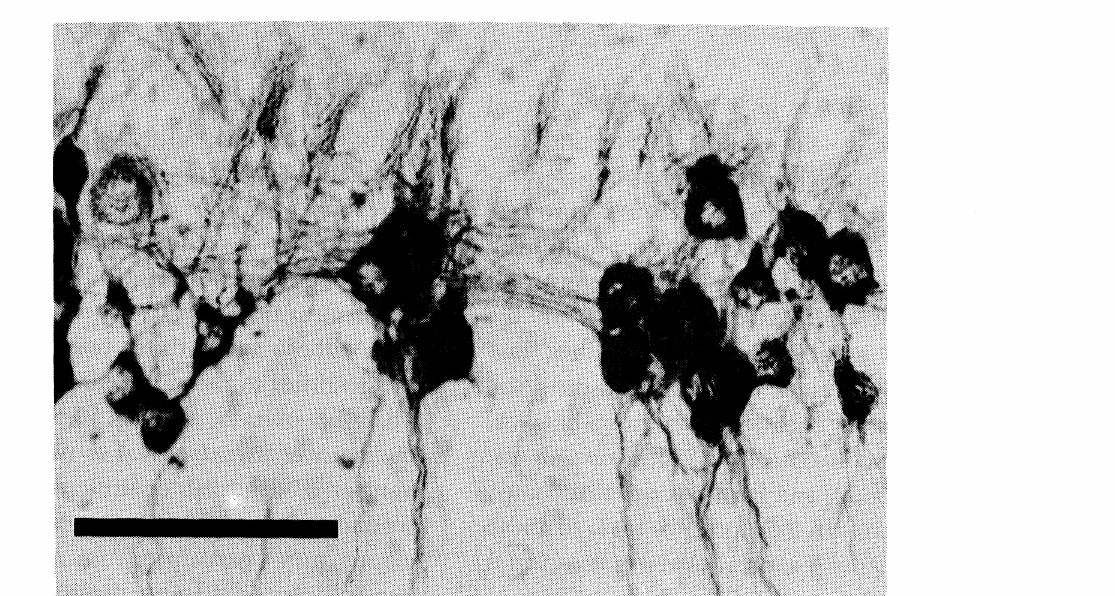
Fig. 2: Motoneuronal pool of the multifidus muscle at P9; horizontal section. Nearly art dendrites are organised in transversal or longitudinal dendrite bundles. Scaling bar, 100 tm; this bar indicates the medial side.dendrites, taking place in 3 to 4 days, occurred simultaneously in the pools innervating the multifidus muscle and the longissimus